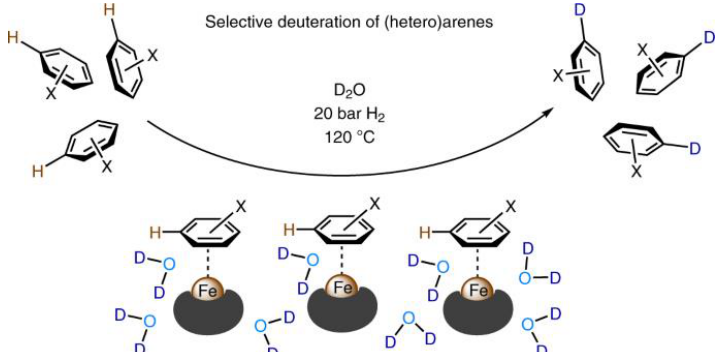
Figure 17. Selective deuteration of (hetero)arenes over Fe-Cellulose-1000. Reprinted with permission from Ref. [93]. Copyright 2022, Springer Nature.